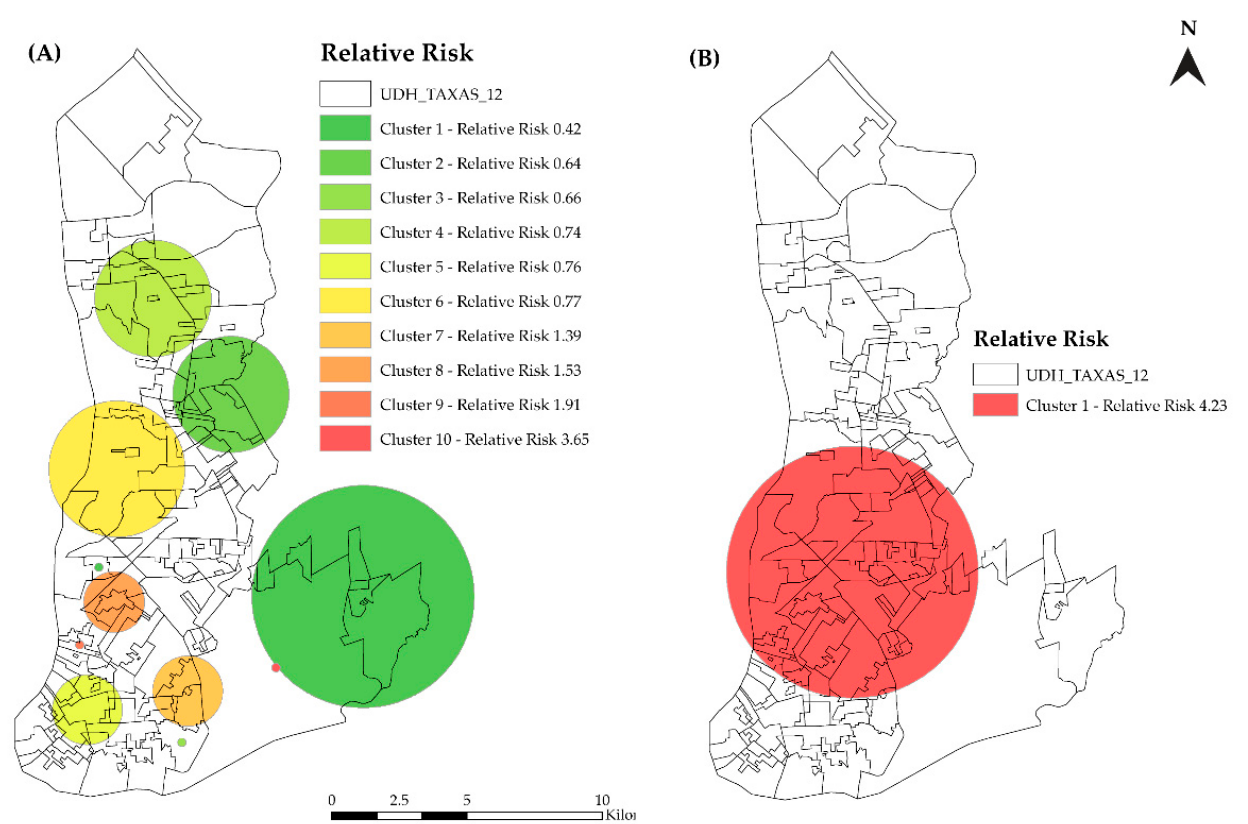
Figure 6. ( A ) Spatial clusters of new reported cases of HIV/AIDS. ( B ) Space–time cluster of new reported cases of HIV/AIDS in Belém, PA, Brazil (2007–2018).